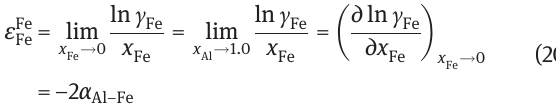
Figure 5: Comparison of reported Raoultian activity coefficient ln γ 0 model (a) or comparison of reported results of standard molar Gibbs free energy change Δ sol G Θ ,% obtained ones by developed AMCT – N i model (b) for Fe – Al binary melts over a temperature range from 1373 to 1973 K (1100 to 1700°C),